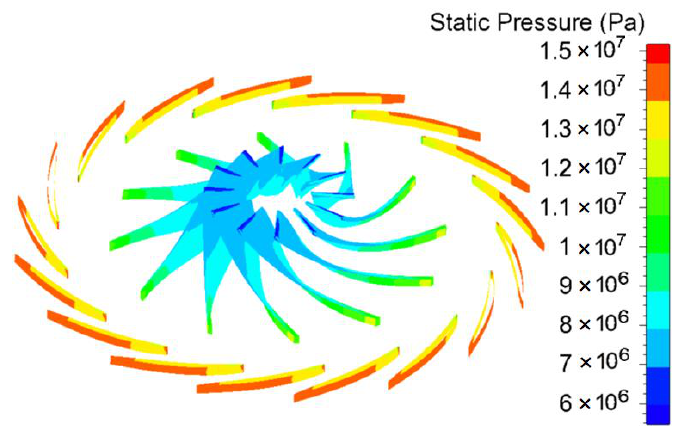
Figure 16. The pressure distribution of the blade surface.